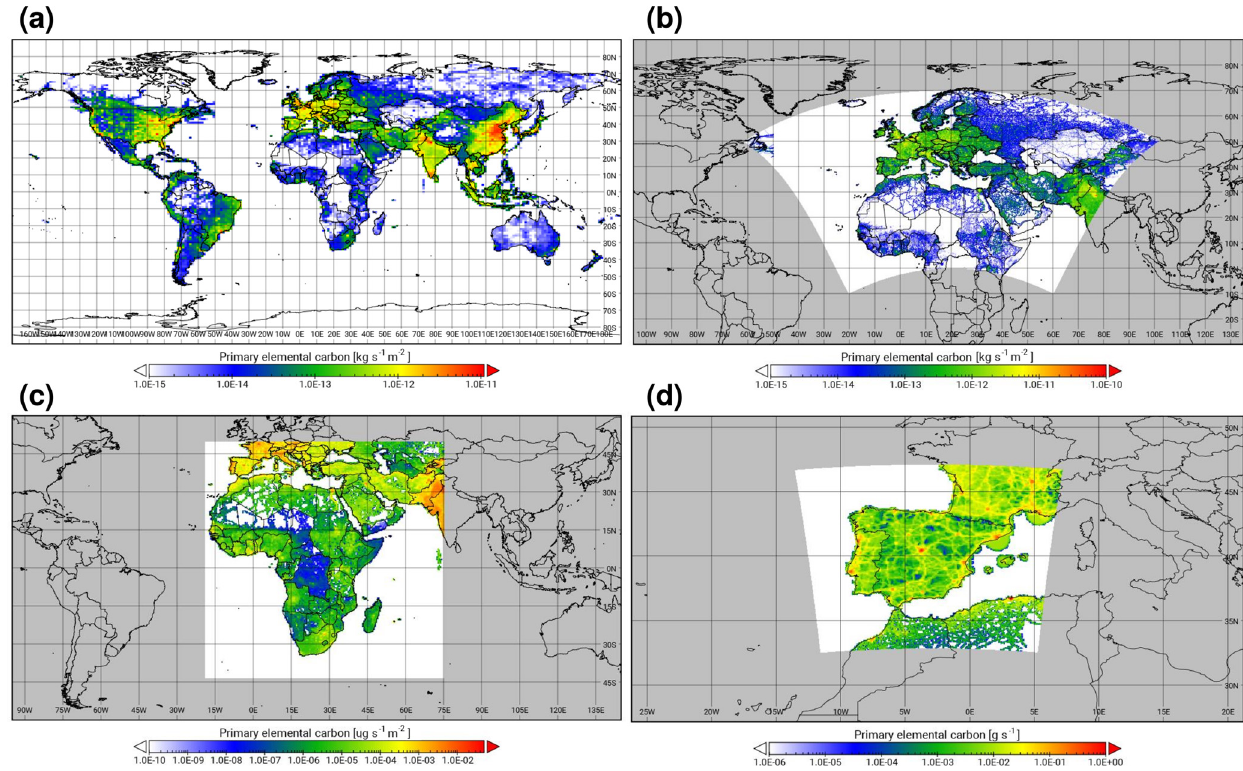
Figure 3. Examples of the HTAPv2.2 black carbon transport emissions regridded onto a 1 ◦ × 1 . 4 ◦ global regular lat–long domain (a) , 0 . 1 ◦ × 0 . 1 ◦ rotated lat–long domain (b) , 50km × 50km Mercator grid (c) and 4km × 4km Lambert conformal conic grid (d) . All maps are displayed in an equirectangular projection.